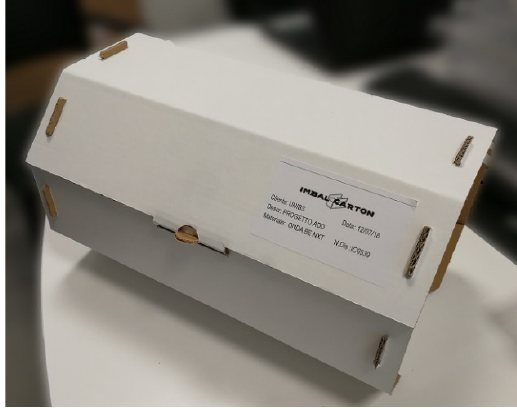
Figure 2. Prototype of the final packaging design in folded configuration.